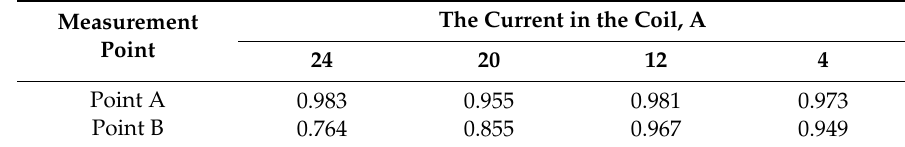
Table 1. The coe ffi cient of correlation between the experiments and the